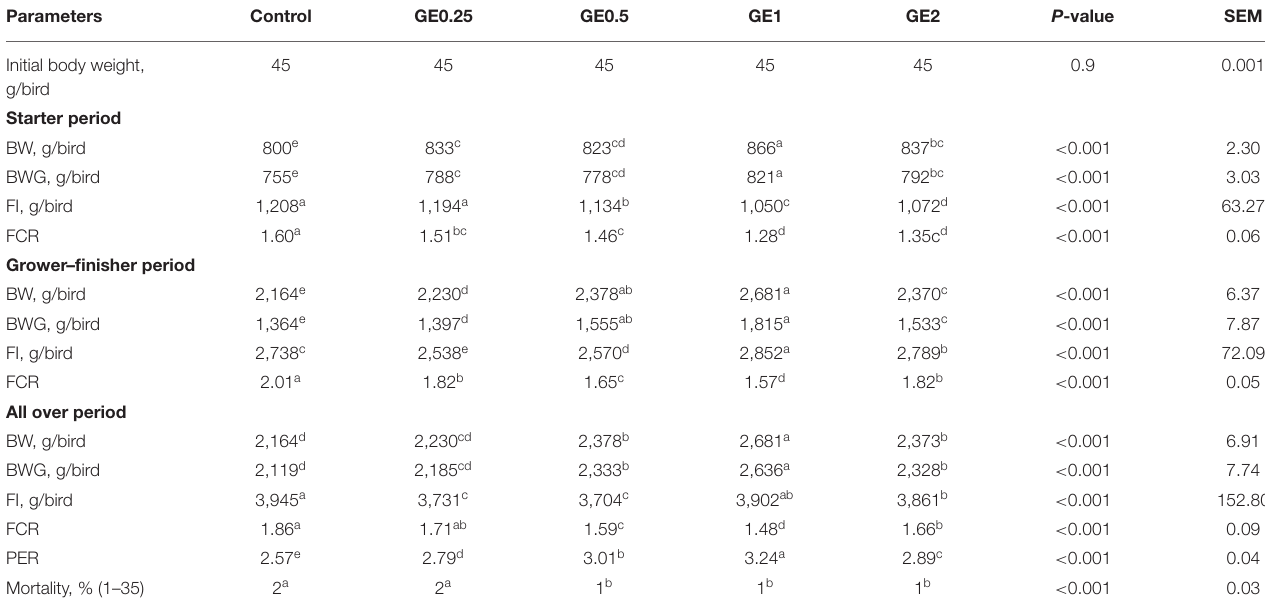
TABLE 3 | Effects of dietary supplementation of Glycyrrhiza extract on growth performance of broiler chickens over 35 days.